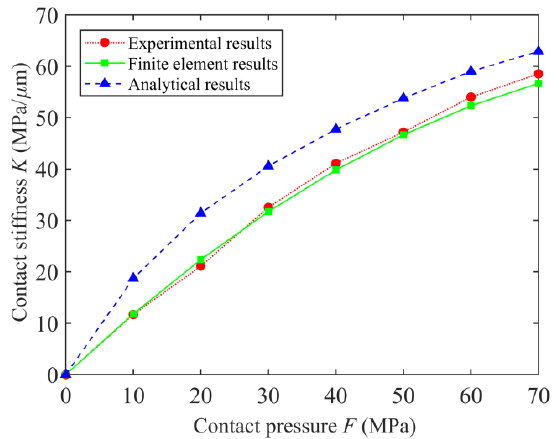
Figure 6. Comparison results of normal contact stiffness under different methods.